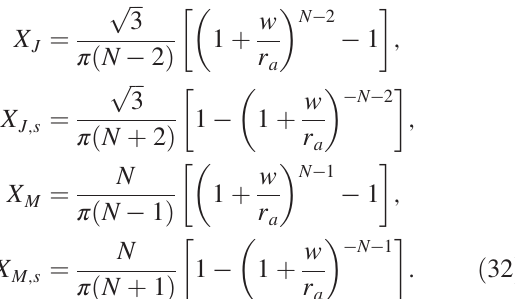
for sector coils a